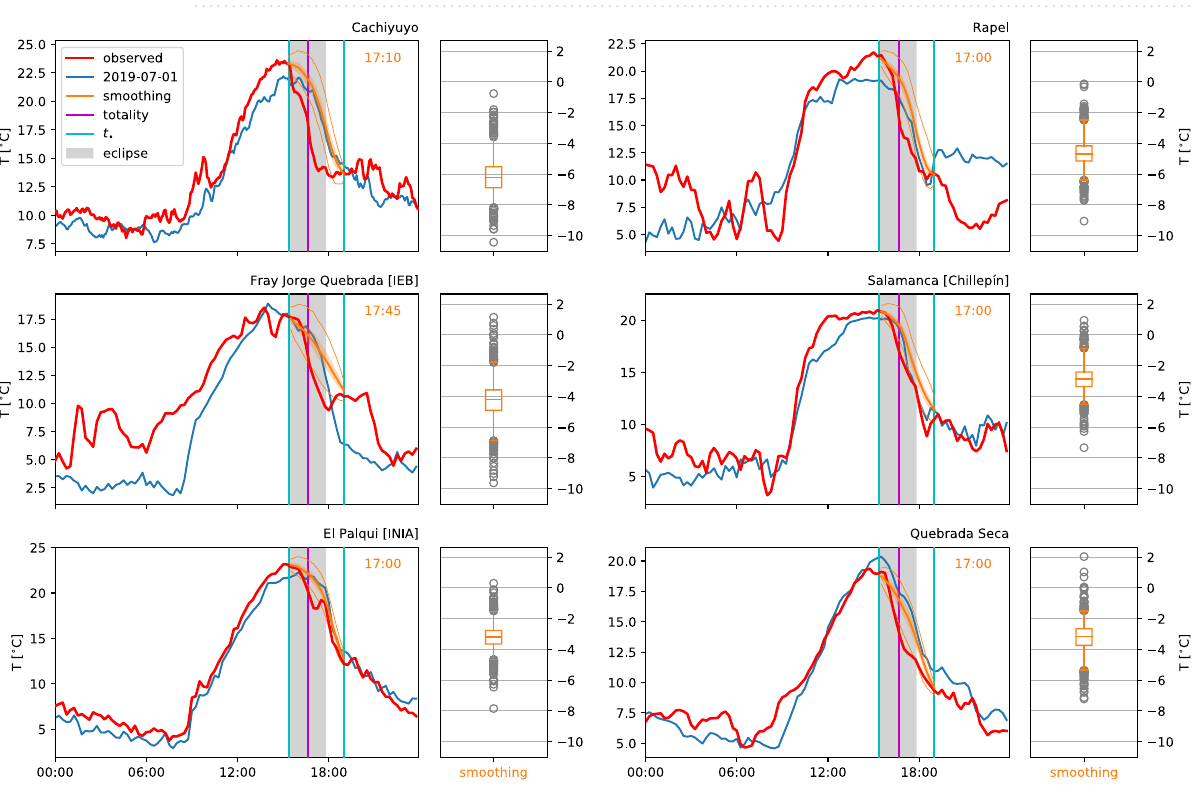
Figure 7. Observed 2 m air temperatures and smoothing lasso reference estimates for the day of the eclipse as in Fig. 1, but for the stations with the largest (cid:31) T estimates. Additionally, the observed temperatures during July 1st, 2019 (the day preceding the eclipse) are shown, to give an idea of the realism of the